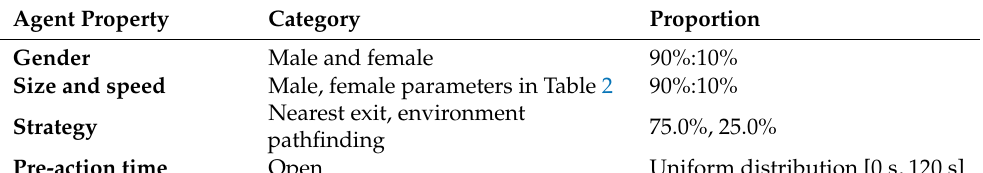
Table 3. Constructor parameters in analysis of construction layout’s influence.